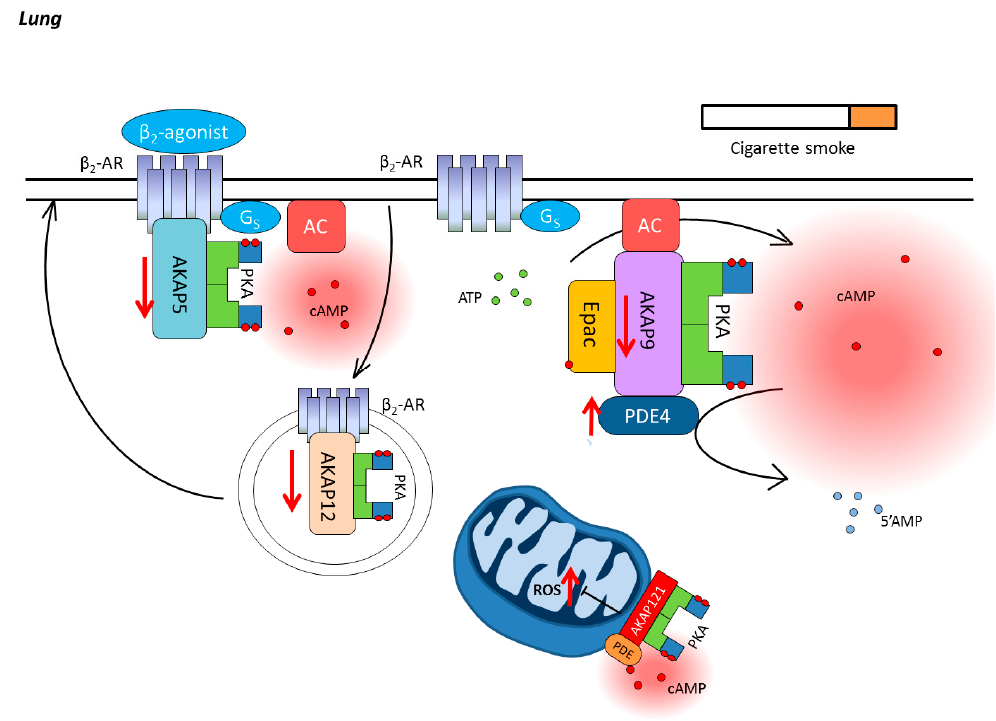
Figure 3. cAMP compartmentalization in COPD. As one of main inducing factors, cigarette smoke (CS) is able to modulate numerous molecular signals in both structural and inflammatory cells in the lung. CS decreases the expressions of A-kinase anchoring protein (AKAP)5 and AKAP12, thus, regulating the effect of β 2 -agonists on COPD pathological development. Moreover, CS interferes with cAMP compartments by AKAP9, which binds and regulates the function of adenylyl cyclases (ACs). In addition, intracellular cAMP concentration is further decreased by upregulating cAMP hydrolyzing enzyme PDEs expression. β 2 -AR, β 2 -adrenergic receptor; AC, transmembrane adenylyl cyclase; cAMP, cyclic adenosine monophosphate; ATP, adenosine triphosphate; PDE4, phosphodiesterase 4; AKAP, A-kinase anchoring protein; PKA, protein kinase A; Epac, exchange protein directly activated by cAMP; ROS, reactive oxygen species.